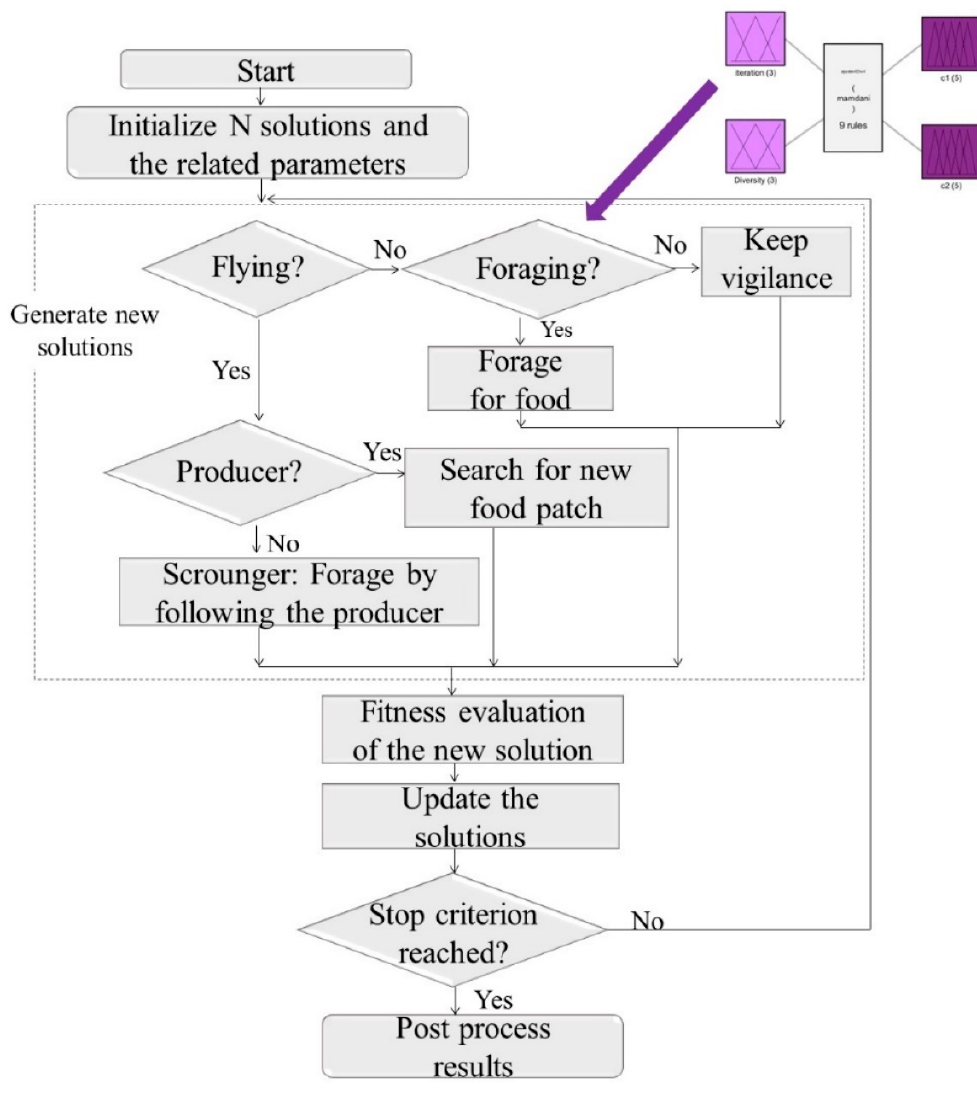
Figure 2. Proposed method of the dynamic bird swarm algorithm.